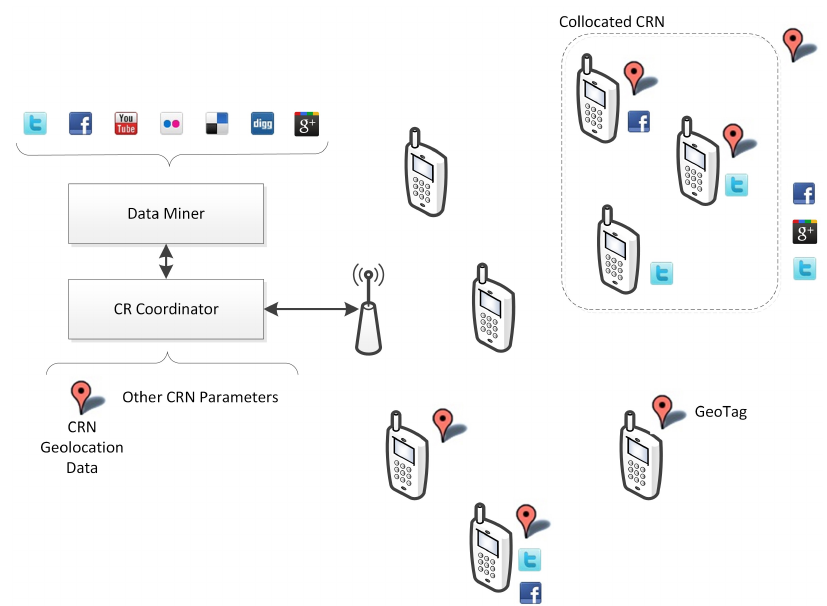
Figure 2. The proposed data mining-informed cognitive radio (DMICR) system utilizes other data sources in addition to the usual parameters employed in cognitive radio networks